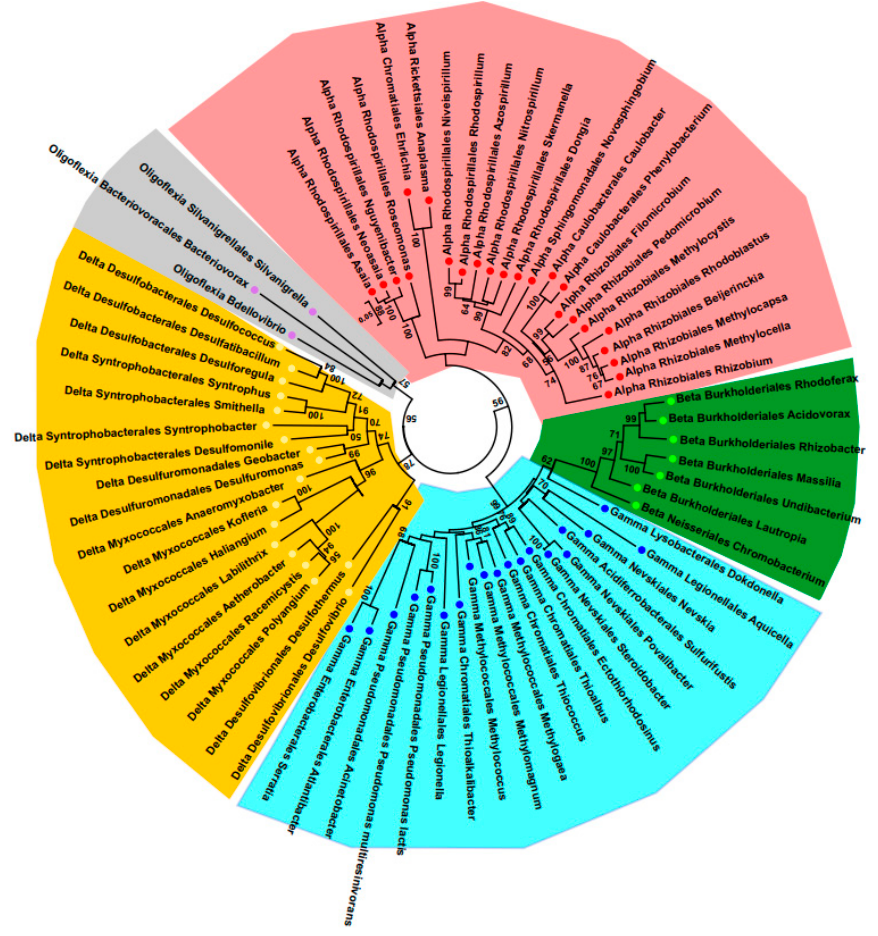
Figure 8. Taxonomic diversity of Proteobacteria in the microbiome of the root-associated biofilm. Red circles—Alphaproteobacteria, blue circles—Gammaproteobacteria, yellow circles—Deltaproteobacteria, green circles—Betaproteobacteria, purple circles—Oligoflexia.